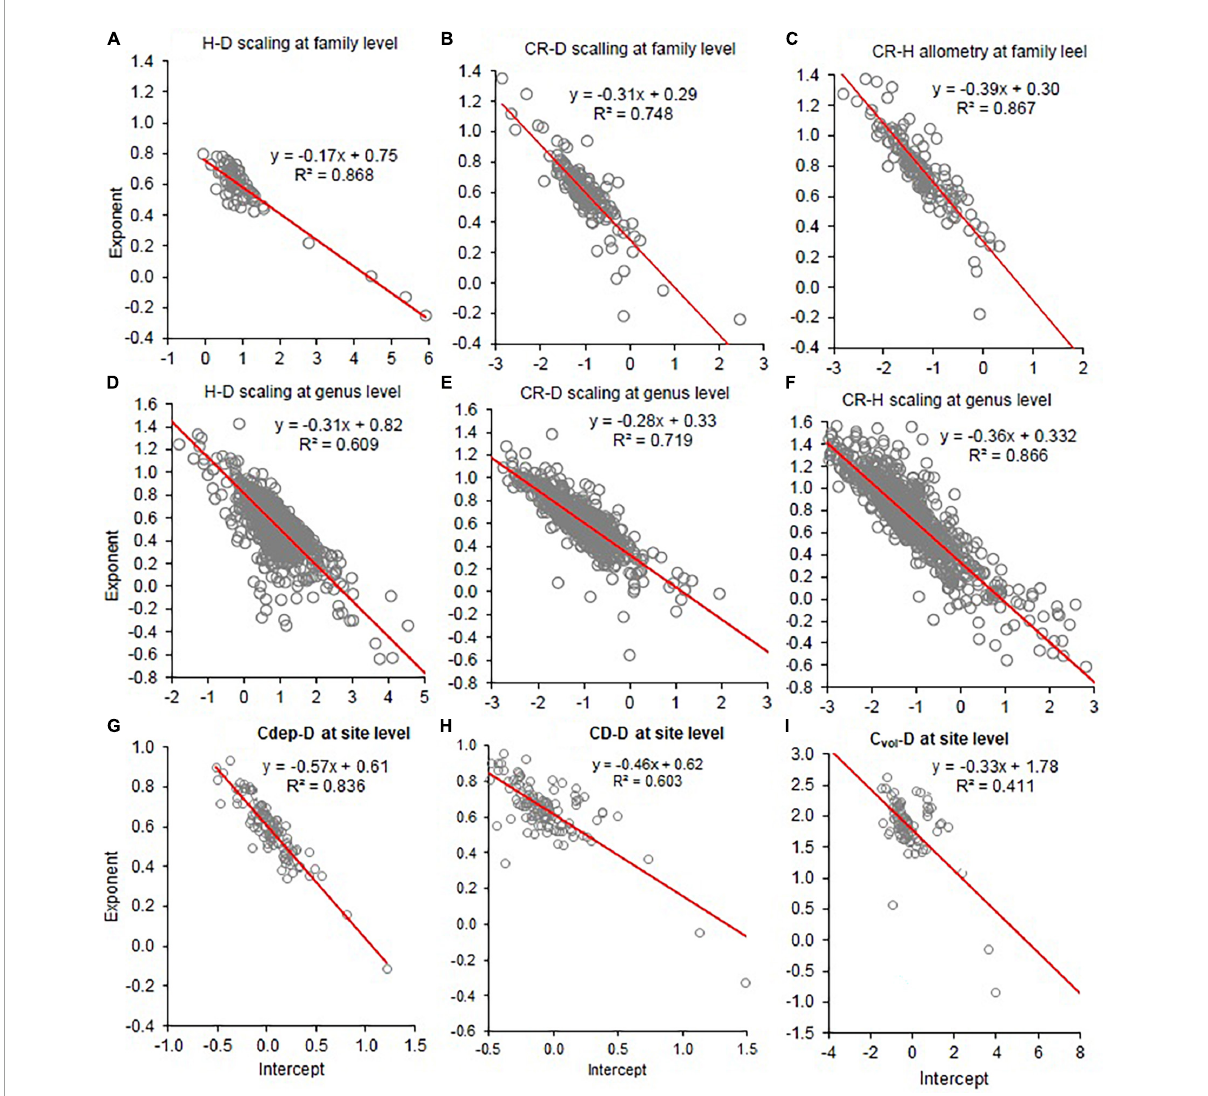
FIGURE7 Co-variation of the allometry exponents ( β ) with the intercepts (In α ) of height to stem diameter (H–D), crown radius to stem diameter (CR–D), crown radius to stem height (CR–H), crown depth to stem diameter (CDep–D), crown diameter to stem diameter (CD–D), and crown volume to stem diameter (Cvol–D) at the family (A–C) , genus level (D–F), and sites (G–I) . The red line represents the fitted line of the linear regression of β on In α